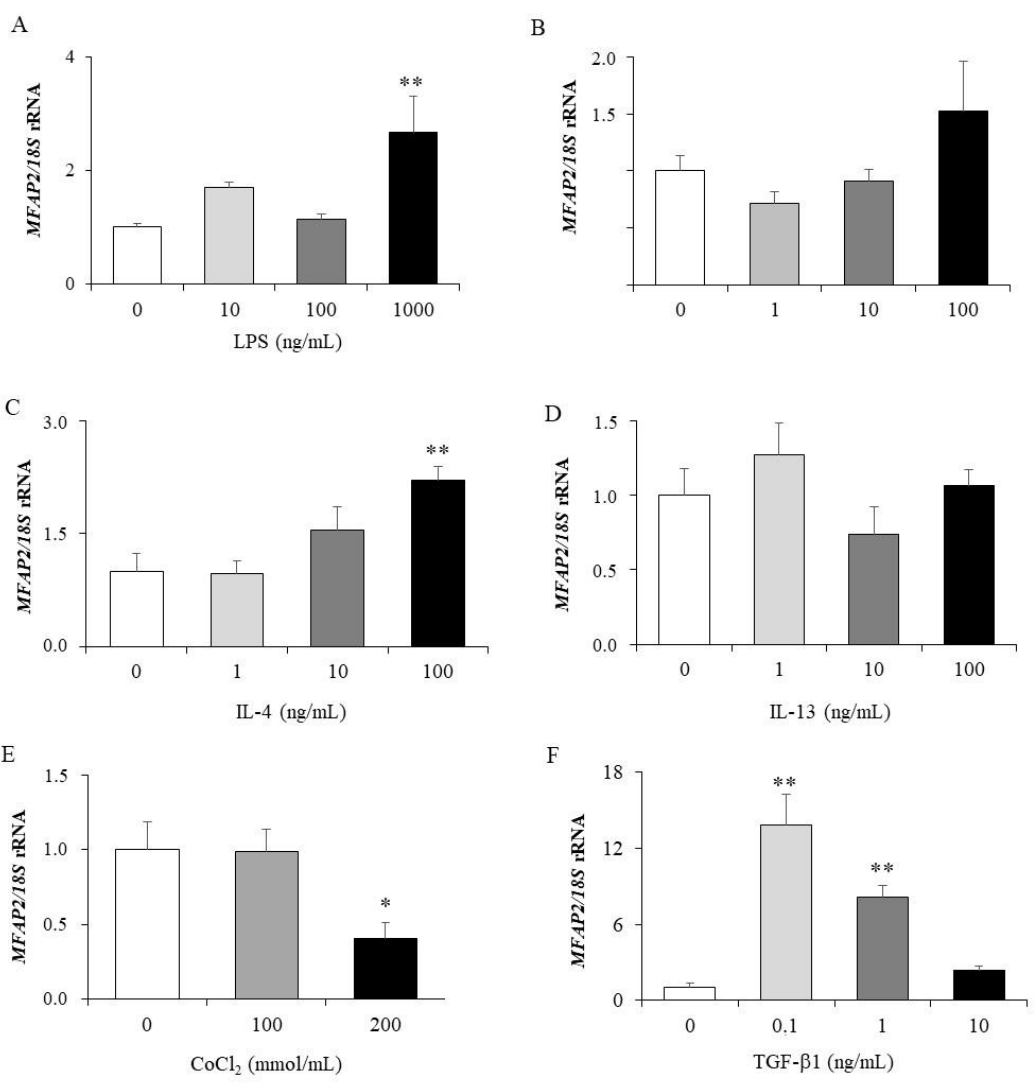
Figure 2. MFAP2 gene expression levels in HT-29 cells treated with different concentrations of LPS ( A ), TNF- α ( B ), IL-4 ( C ), IL-13, ( D ), CoCl 2 ( E ) and TGF- β ( F ). Gene expression levels in unstimulated cells were assumed to be 1. Values are the mean ± SEM ( n = 6 per group). Differences between groups were analysed by one-way ANOVA followed by Dunnett’s post-hoc tests. * p < 0.05, ** p < 0.01 vs. unstimulated cells.